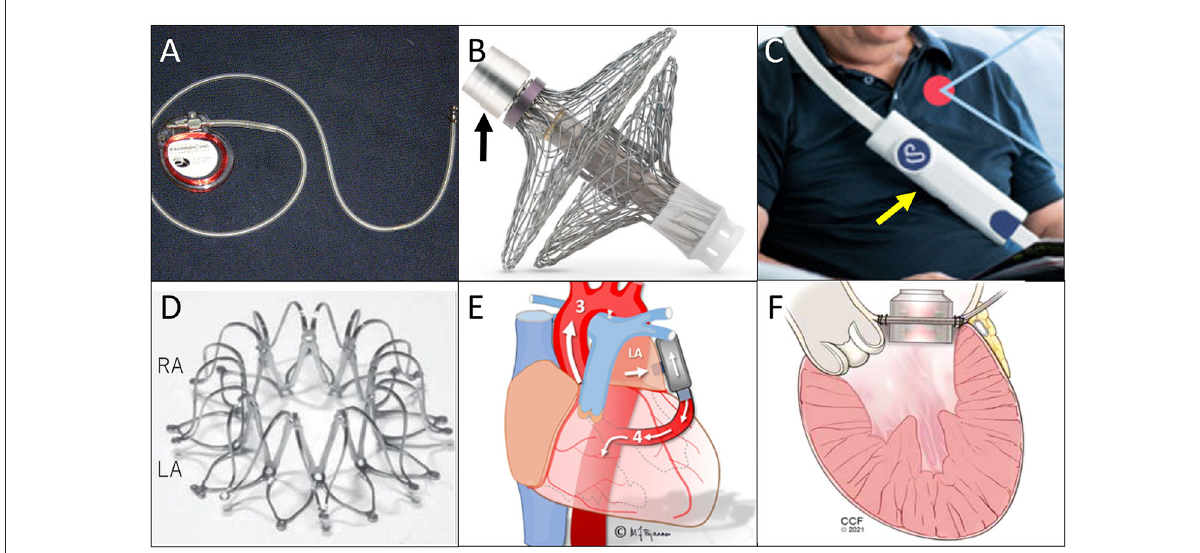
FIGURE1 Illustrations of each device. (A) Heart POD, quoted from (6); (B) Sensory implant of V-LAP System (black arrow is the pressure-sensing assembly connected to electronic circuitry), quoted from (6); (C) Sensor of V-LAP (yellow arrow), quoted from (15); (D) Corvia Atrial Shunt Device, quoted from (19); (E) PulseVAD, quoted from (30), and; (F) Left Atrial Assist Device, quoted from